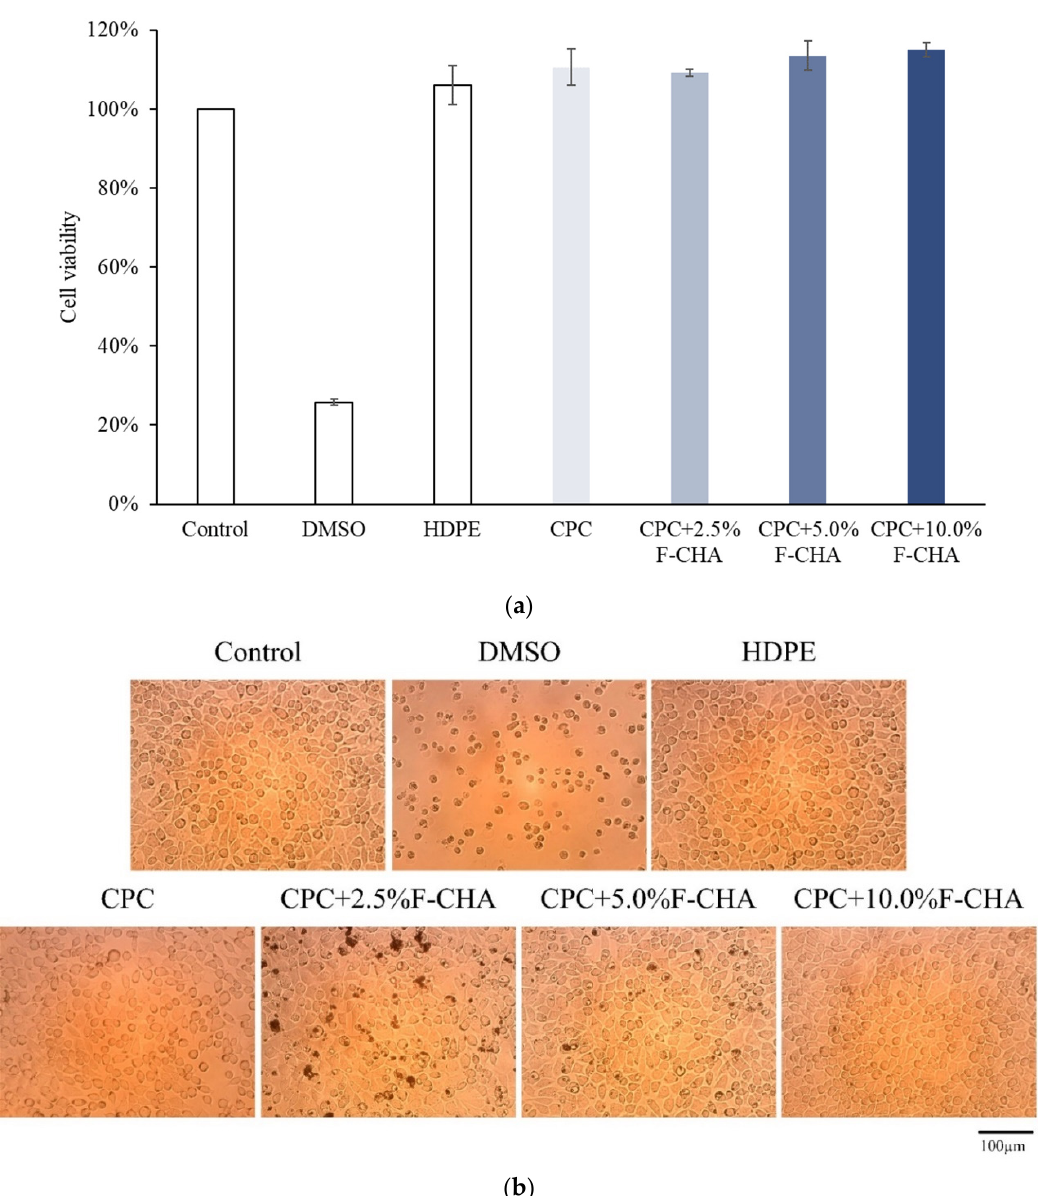
Figure 10. Quantitative cell viability ( n = 6) ( a ) and qualitative cell morphologies ( b ) of L929 cells cultured for 24 h in solutions of CPC only and CPC composites with different ratios of ferulic acid-carbonated apatite nanorods (F-CHA).